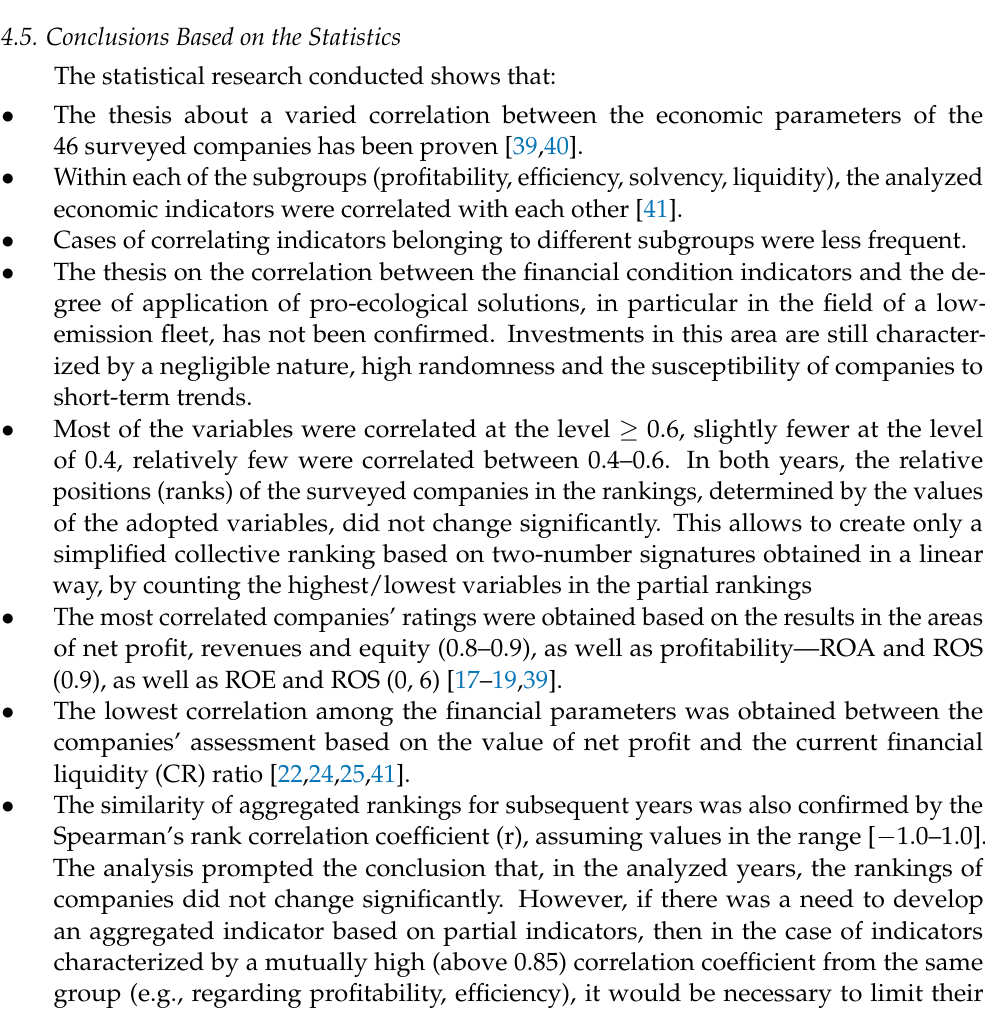
Scheme 3. Aggregated ranking of top ten LSP companies based on signaturization. Based on own research.